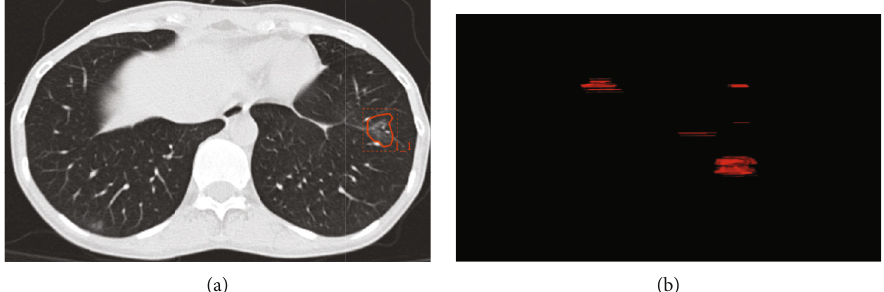
Figure 1: A case of con fi rmed mild COVID-19. A 33-year-old female presented with a 2-day history of fever and cough. (a) CT imaging revealed di ff use pure GGO with distribution in the left lower lobe. The area of the lesions was delineated on the axial. (b) The reconstructed images.